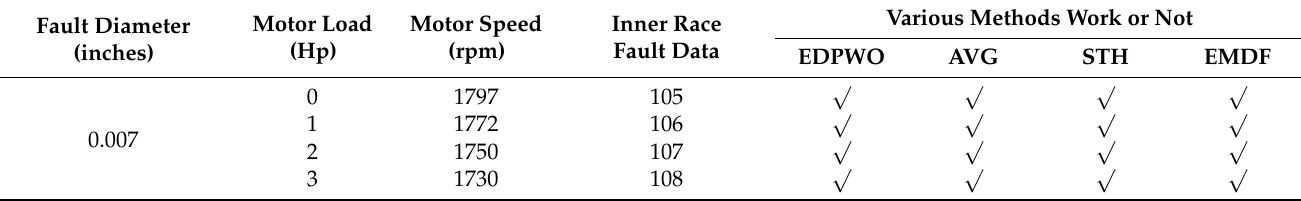
Table 5. Statistical evaluation results on all available signals from 12 k drive end of